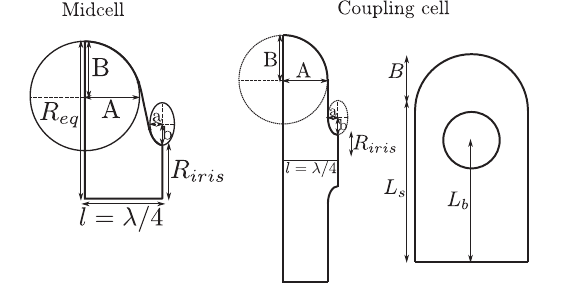
FIG. 6. Schematic of the mid cell (left) and the coupling cell (right).